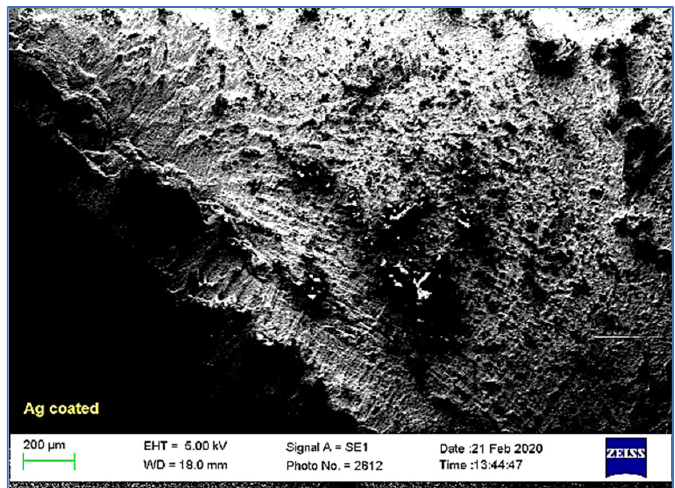
Figure 8. SEM surface morphology image of Ag-coated pellet showing a reasonably rough but well-coated surface without pinholes.